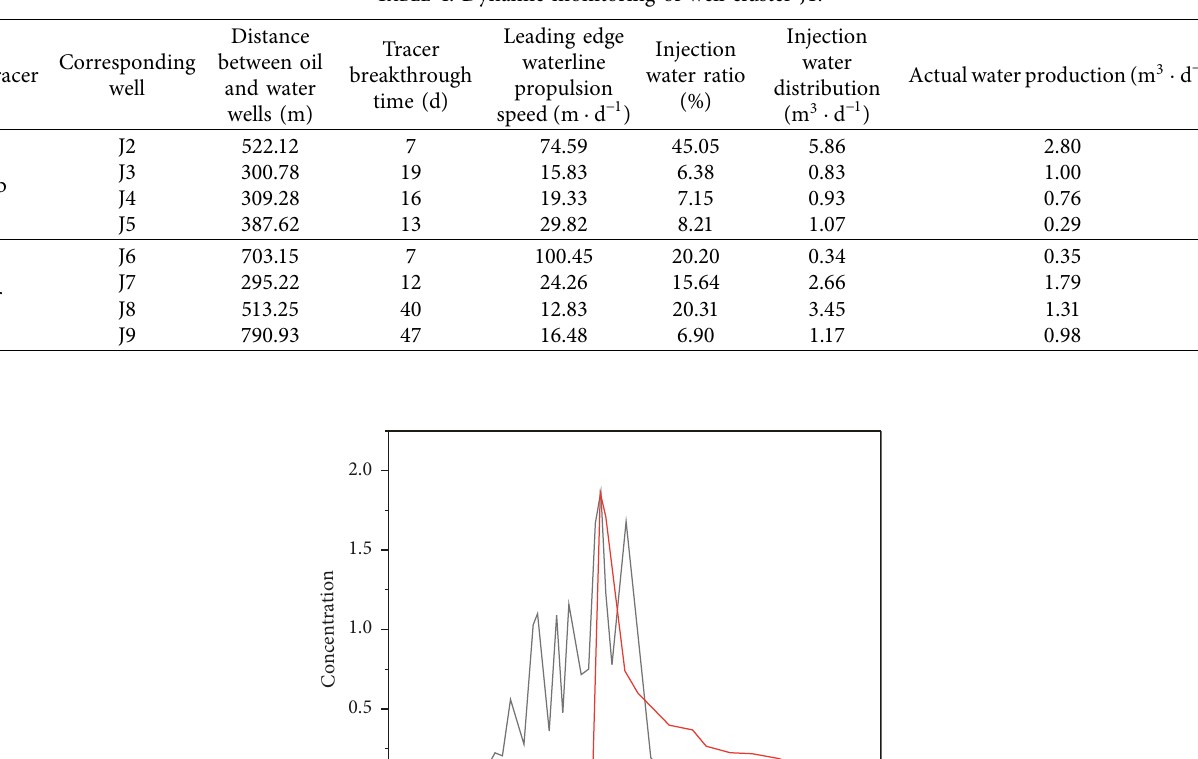
Table 4: Dynamic monitoring of well cluster J1.